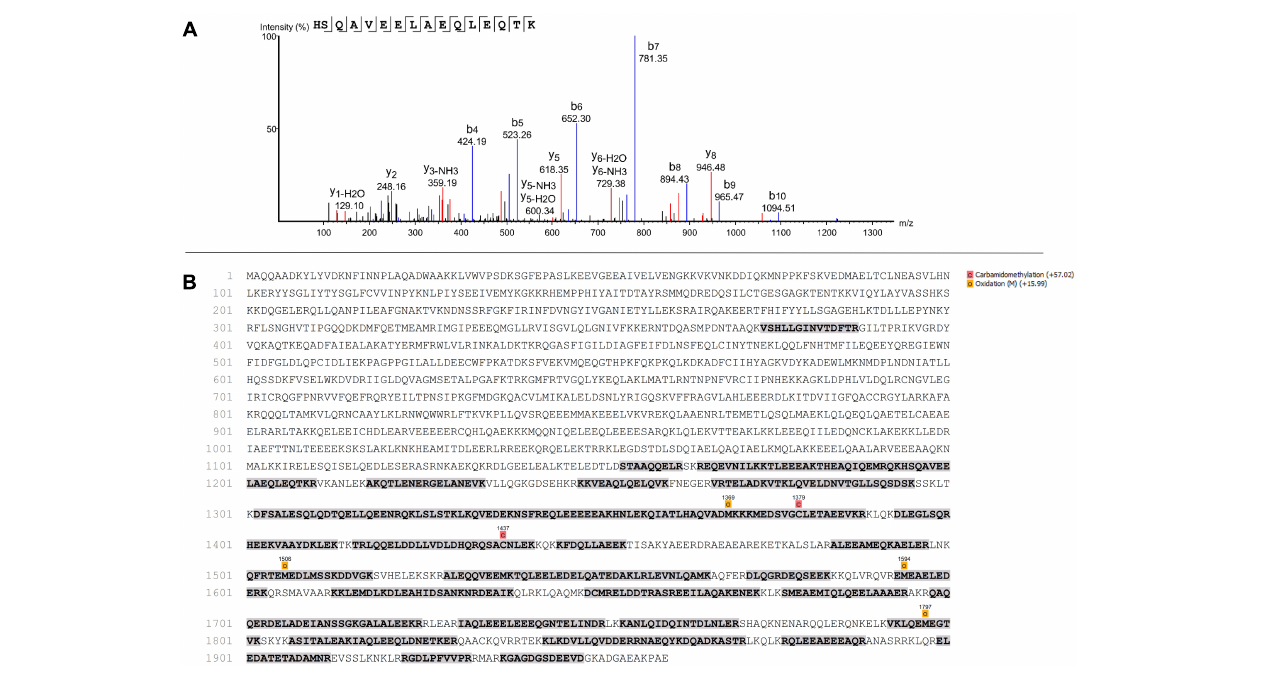
FIGURE 5 | Mass spectrometry showing identification of peptide and sequence coverage of myosin-9. Results from one mass spectrometry analysis of the ∼ 100 kD band from an 8D4-8 immunoprecipitation of staurosporine-treated PBL. In total, 2 control and 2 staurosporine-treated samples were analyzed from 2 separate experiments. (A) Identification of peptide representing sequence from 1194 to 1209 of myosin-9. (B) Sequence coverage (31%) of myosin-9.